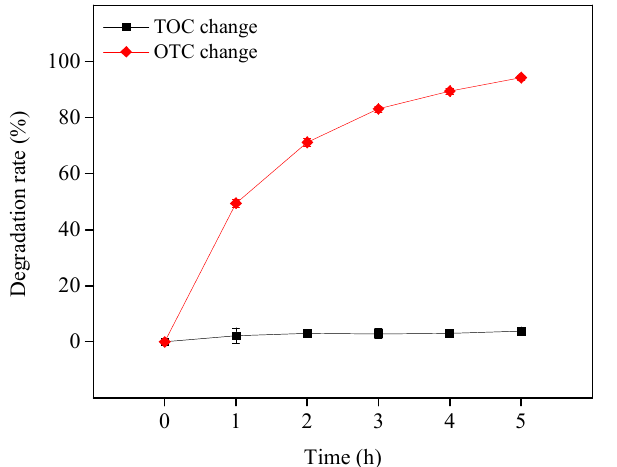
Figure 7. OTC mineralization in the visible light/TiO 2 system at pH 8.6. Experimental conditions: [OTC] 0 = 10 mg L − 1 , [TiO 2 ] 0 = 0.5 g L − 1 , 50 mM phosphate buffer.